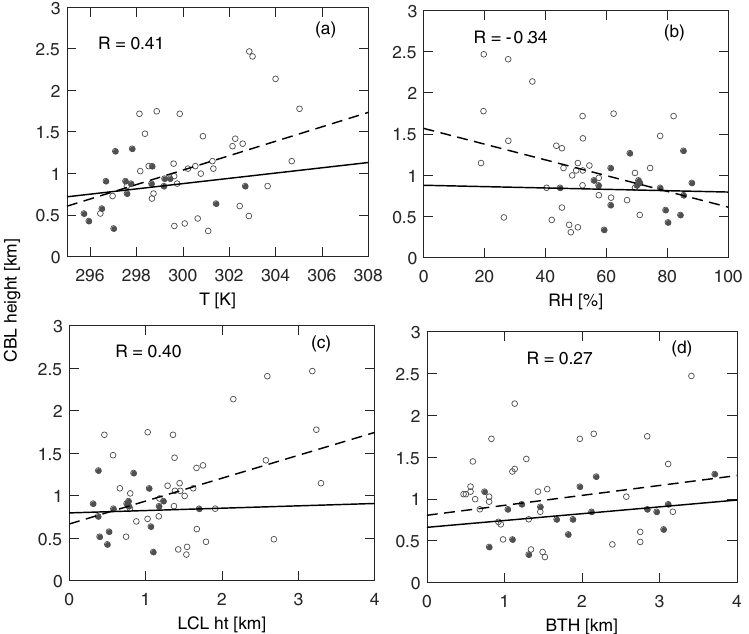
Figure 9. Scatter plot between the CBL height, (a) surface temperature, (b) relative humidity, (c) LCL height, and (d) BTH observed over six stations. Open circles indicate the cases during clear-sky conditions, which also include FWBL and CTBL cases. Solid circles indicate cloudy conditions based on RH > 83% criteria with cloud having a vertical extent of more than 1km. Dashed and solid lines represent the regression lines for clear-sky and cloudy conditions, respectively.